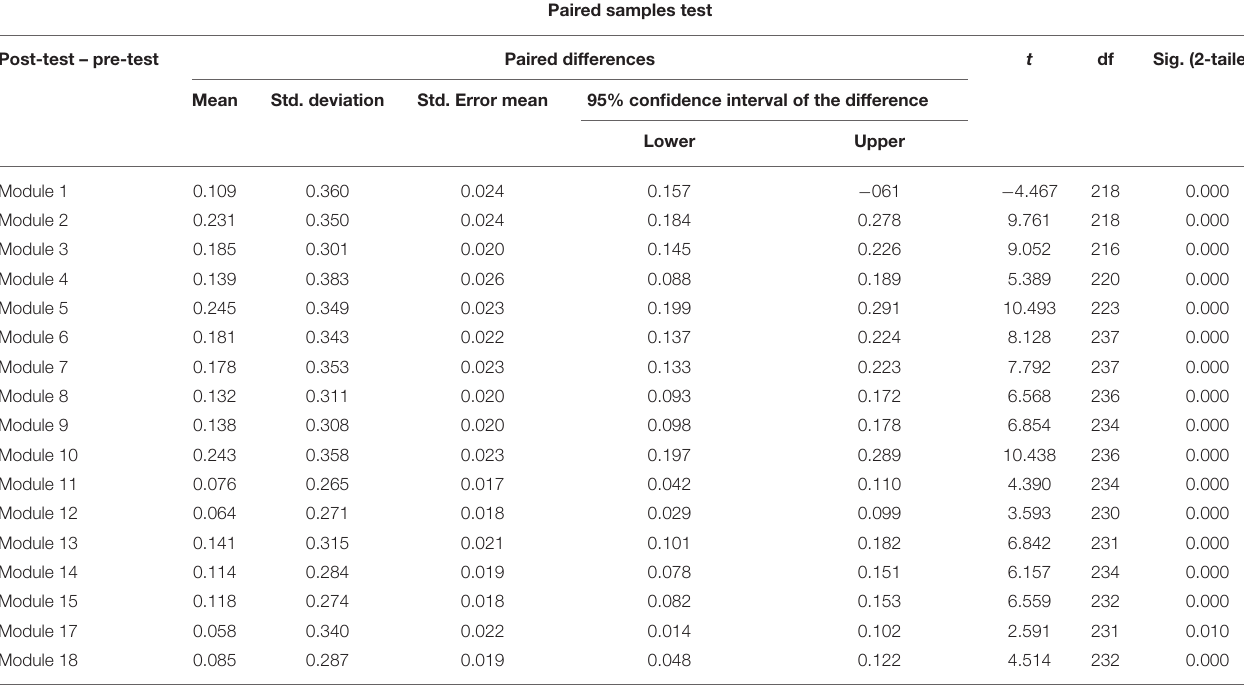
TABLE 3 | Students’ learning gains between pre- and